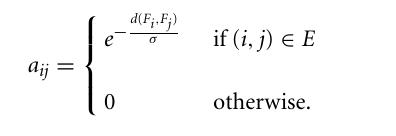
FIGURE 1 | Pipeline of our proposed method. (A) Intra-subject clustering through Dominant Sets. (B) Landmark extraction and centroids encoding on the landmark space. Each centroids selected from